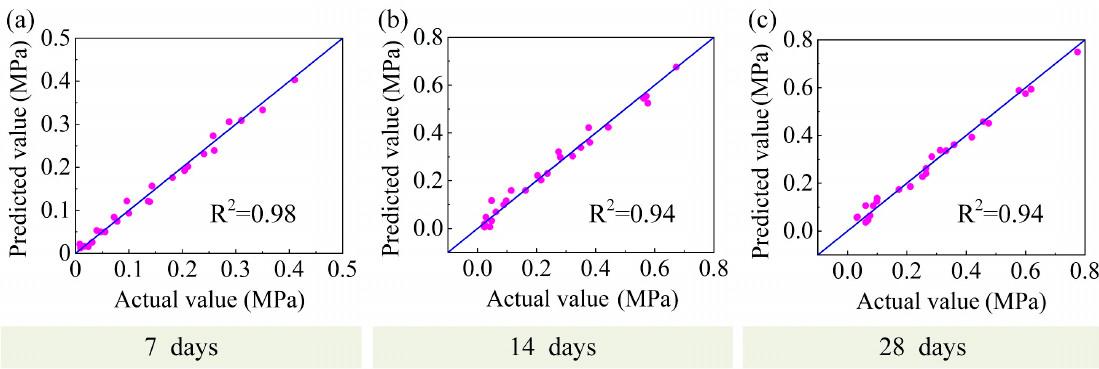
Figure 19. Performances of FL, BL, and IST predicted models. ( a ) FL ( b ) BL ( c ) IST.